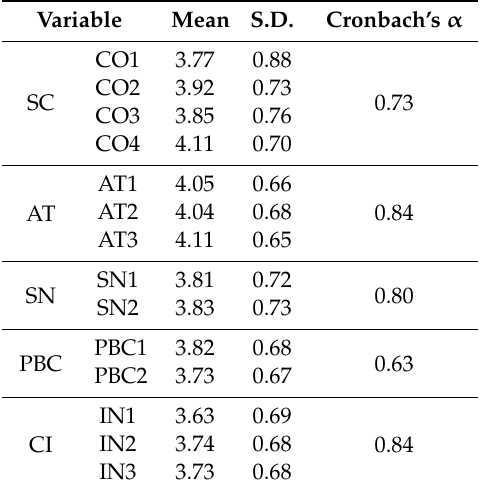
Table 2. Reliability of